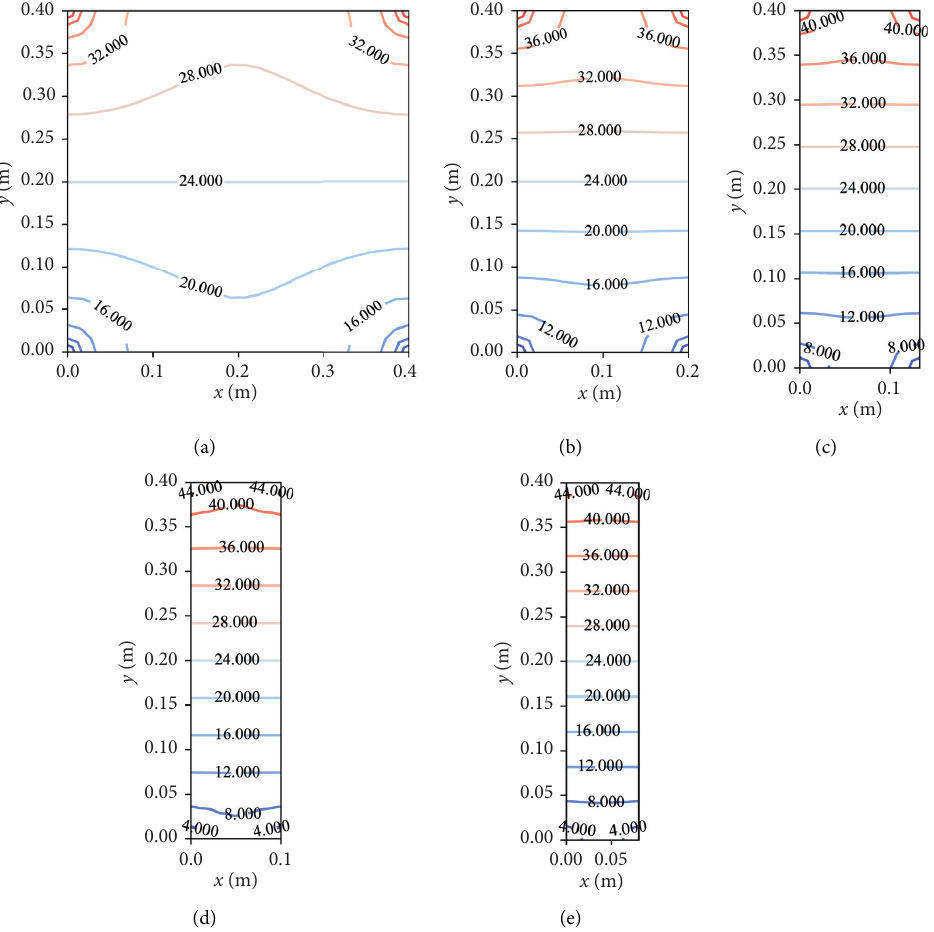
Figure 11: Potentialcontourplotofsymmetricunit.(a) W � 0.4ml � 0.4m. (b) W � 0.4ml � 0.2m. (c) W � 0.4m, L � 0.133m.(d) W � 0.4ml � 0.1m. (e) W � 0.4ml � 0.08m.